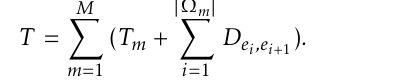
Algorithm 1 Algorithm 1 Community-based